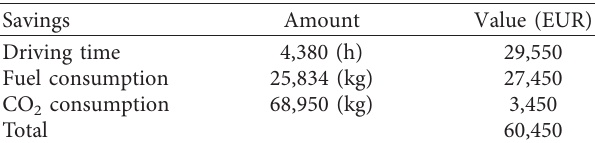
Figure 12: Change of the number of operating vehicles in the function of cycle time. Table 11: Annual savings which would be achieved by applying the proposed model on line